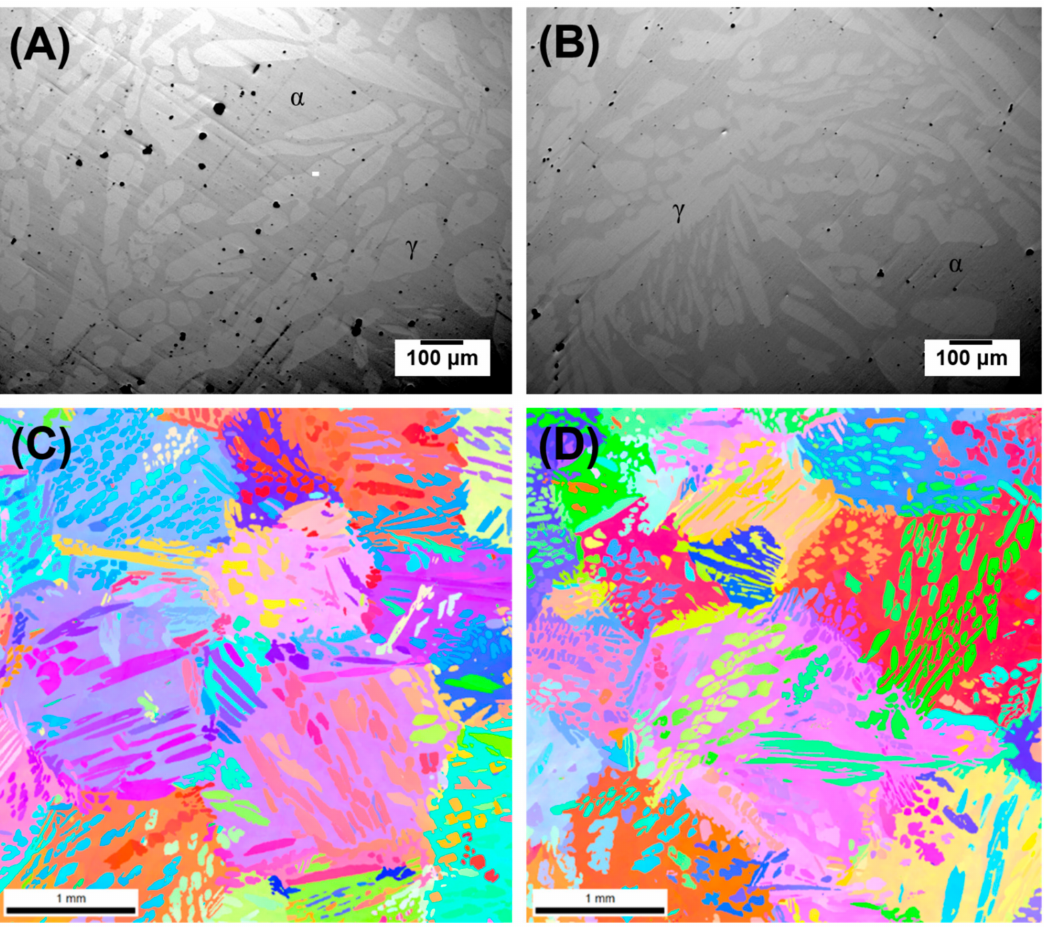
Figure 1. The microstructures of solution-treated duplex stainless steels ( A ) without gadolinium (BDSS) ( B ) with gadolinium (GDSS) and EBSD inverse pole figure maps of ( C ) BDSS and ( D ) GDSS. The ferrite fraction and average grain size of SDSSs evaluated by EBSD mapping are shown in Figure 2. The ferrite contents in BDSS and GDSS were 57.7 ± 3.2% and 59.3 ± 2.4%, respectively,